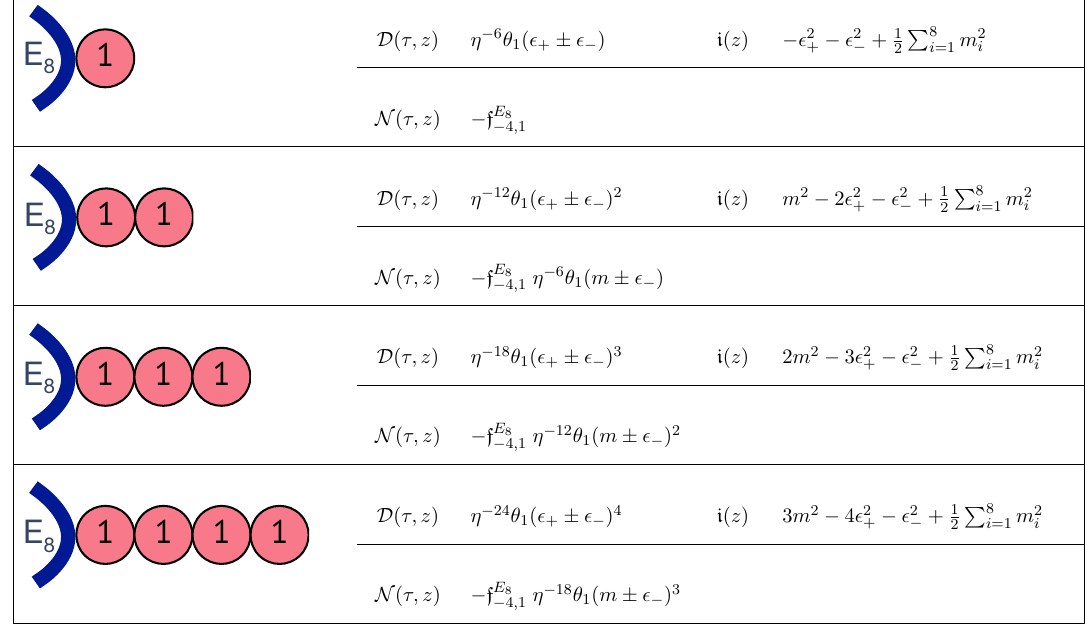
Table 7 . Elliptic genera of string chains in E 8 (cid:2) E 8 heterotic